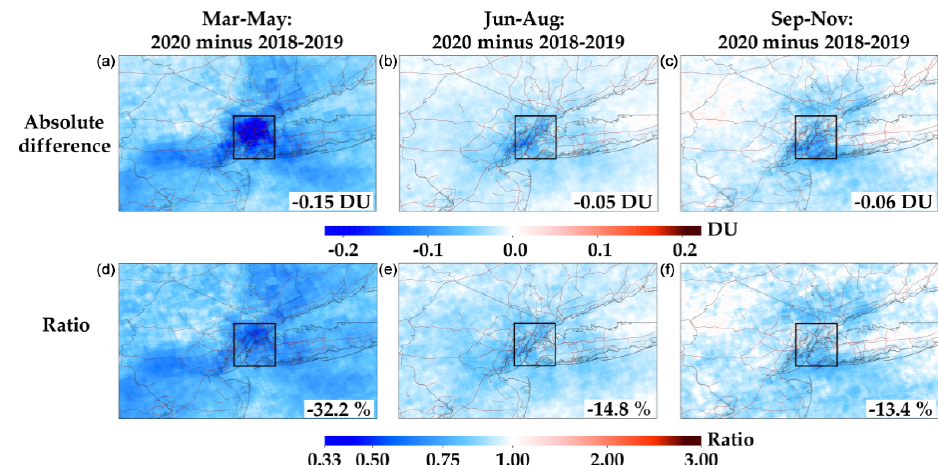
Figure 2. TROPOMI total vertical column NO 2 differences between 2018–2019 and 2020, over the New York metropolitan area. Results are shown for 13 March through May (a, d) , June through August (b, e) , and September through November (c, f) . (a) , (b) , and (c) show the absolute difference between the 3-month period in 2018–2019 and 2020 in Dobson units. (d) , (e) , and (f) show the ratio between the 3-month period in 2018–2019 and 2020. Values denoted in bottom right of each panel are area-averaged difference within a 50 × 50km area around Manhattan (black box). 13 March–29 April 2019 data are double counted in the March through May 2018–2019 period due to